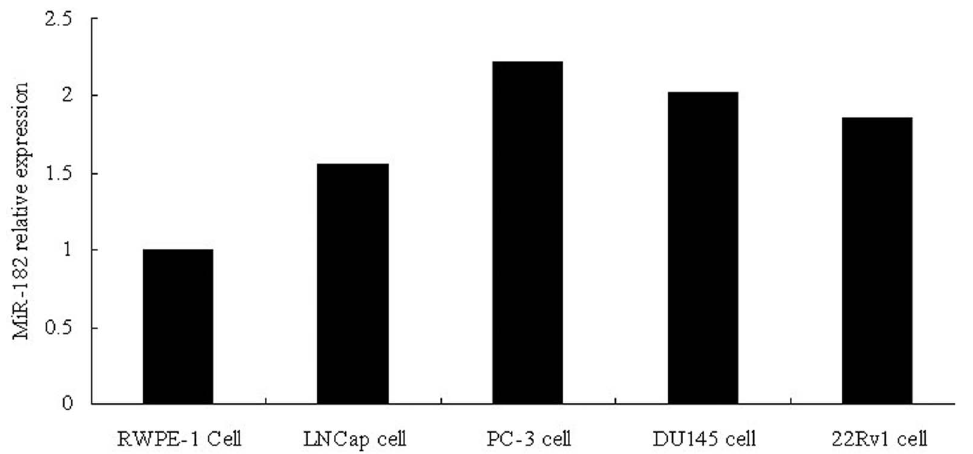
Figure 2. miR-182 expression in different prostate cells measured by real-time RT-PCR. Real-time RT-PCR show that the relative expression level of PC-3 cells is the highest in four prostate cancer cell lines and RWPE-1 has the lowest expression level. Values represent means from three separate experiments and error bars represent the SD.